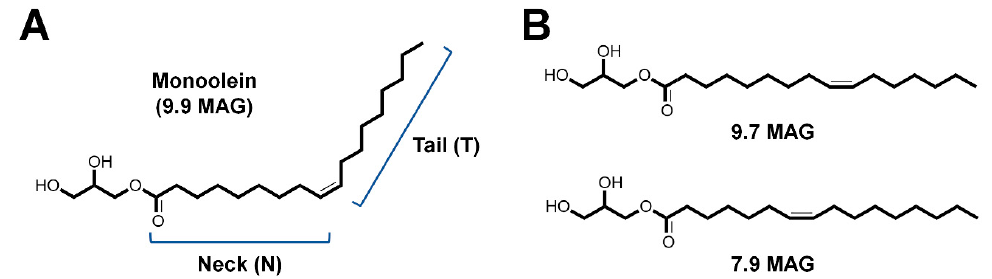
Figure 5. Chemical structure of monounsaturated monoacylglycerol lipids (MAGs). ( A ) Shorthand representation of N.T MAG, where N (neck) is the number of carbon atoms in the acyl chain between the ester and cis-olefin bonds and T (tail) is the number of carbon atoms between the cis-olefin bond and the end of the chain. ( B ) Chemical structure of short MAG lipid 9.7 MAG and 7.9 MAG, used in the SFX experiment in vacuum to avoid the Lc phase of 9.9